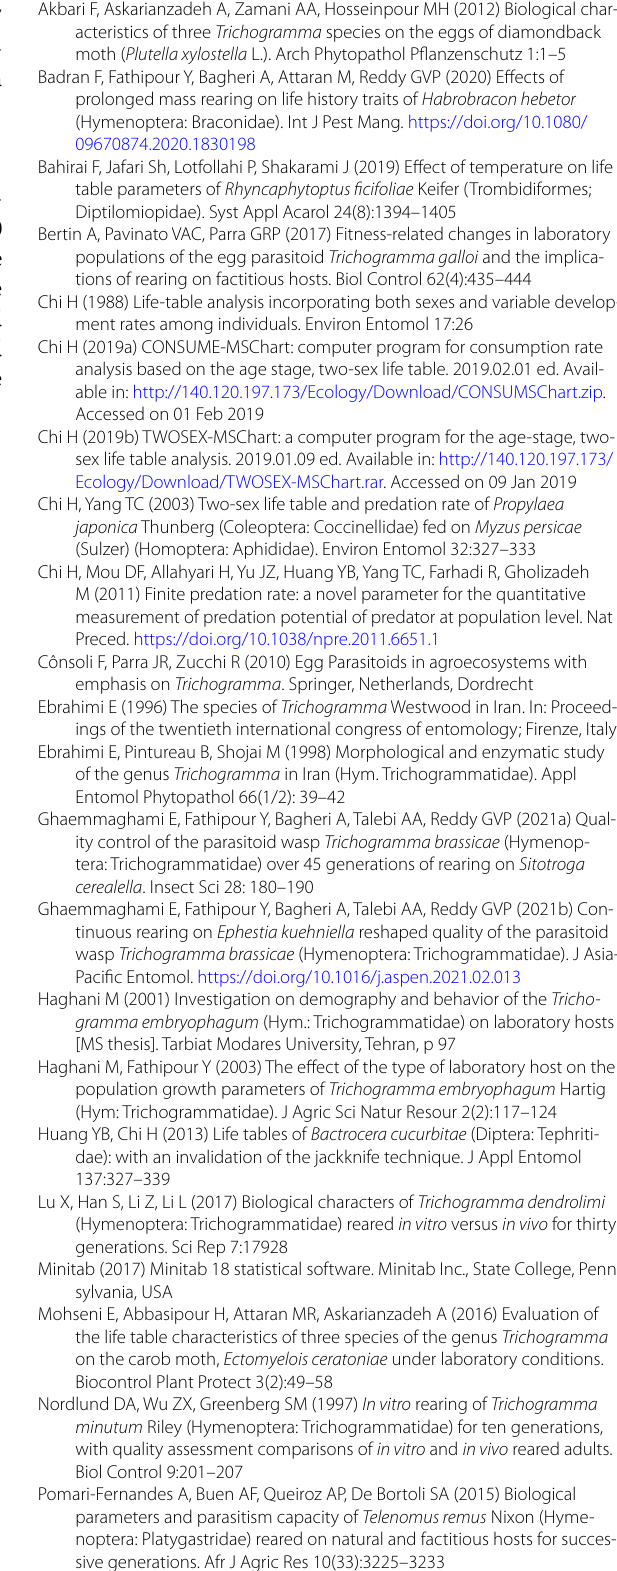
table parameters of Rhyncaphytoptus ficifoliae Keifer (Trombidiformes; Diptilomiopidae). Syst Appl Acarol